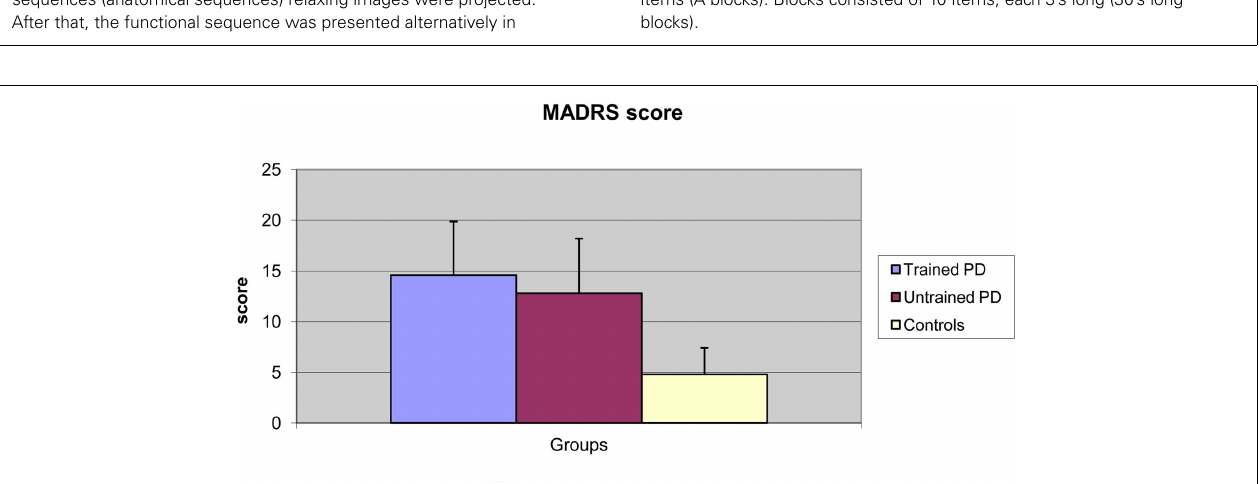
Frontiers in Neurology | Movement